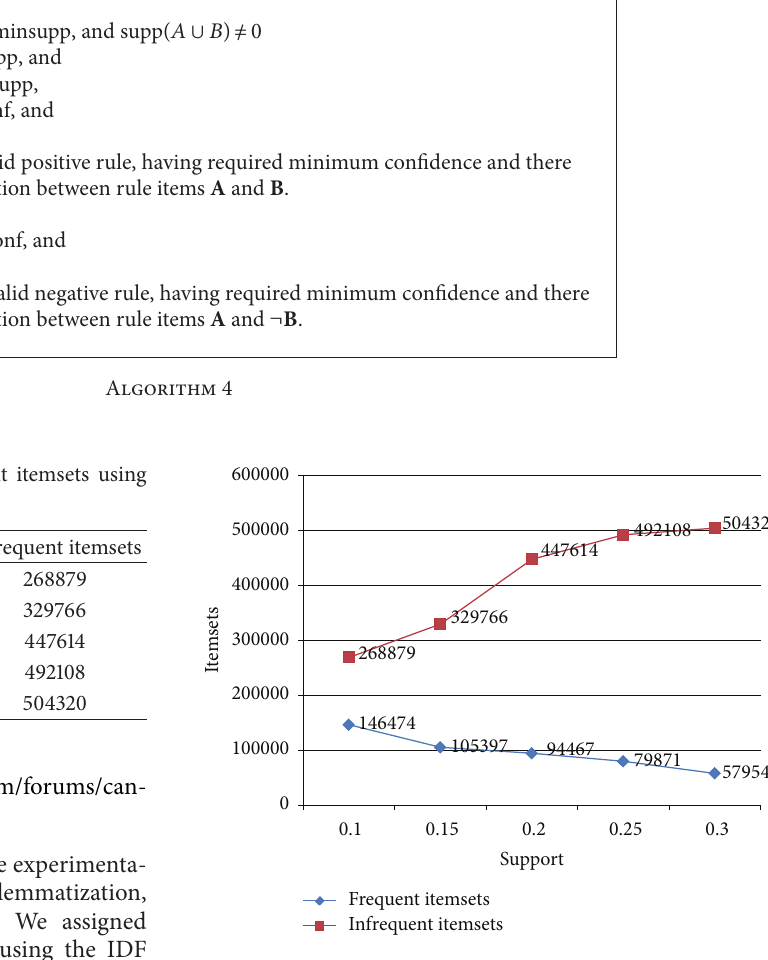
Figure 1: Frequent and infrequent itemsets generated with varying minimum support